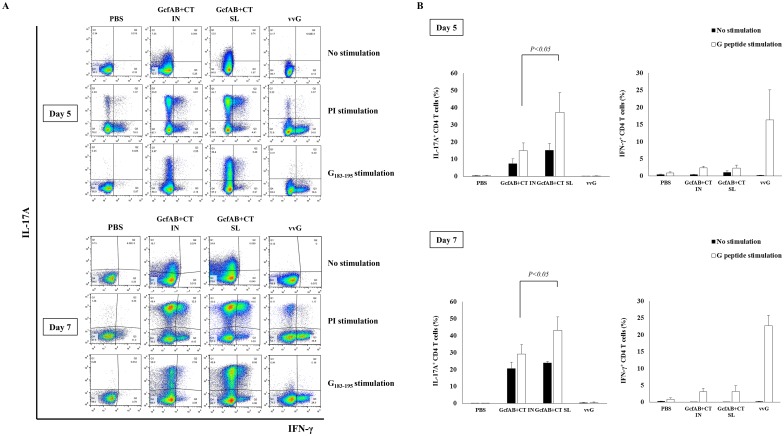
RSV A-specific Th1 and Th17-cell responses in GcfAB-immune mice after RSV A challenge.Five and 7 days after RSV A2 challenge, lung mononuclear cells were isolated from GcfAB-immune mice. Cells were stimulated with PMA (50 μg/ml) and ionomycin (500 μg/ml) as a positive control, or with/without RSV G (a.a. 183–195 of RSV A2 subtype) peptide for 5 hours. Lung cells were stained for anti-CD3, CD4, IFN-γ, and IL-17A antibodies, and were analyzed by flow cytometry. (A) Cells gated for CD3+ CD4+ are shown in dot plots, (B) and the percentage is represented as the frequency of RSV G-specific IFN-γ+ and IL-17A+ CD4 T cells. Data are represented in mean ± SD (n = 4/group). Significant differences from the PBS group are marked with asterisks (*, **). p < 0.05.